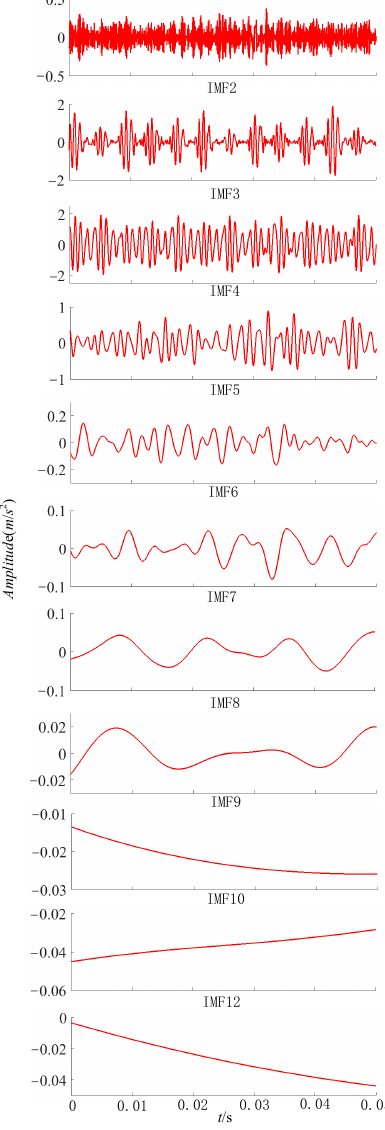
Figure 4. IMF waveforms of vibration signal of main pump in rotor system abnormal state.